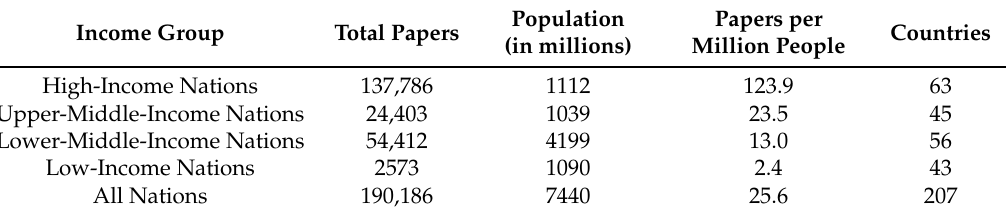
Table 2. Income group level summary